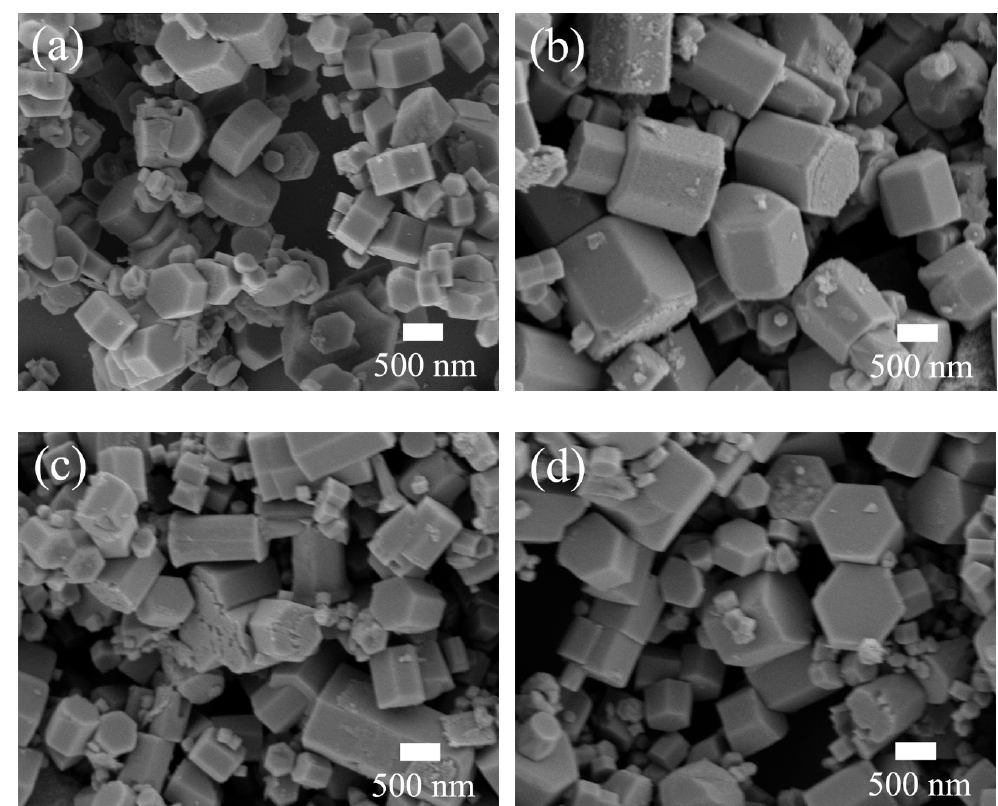
Figure 2. SEM images of undoped ZnO ( a ) and lightly Cu-doped ZnO nanocrystals with different Cu concentrations: ( b ) 0.25%, ( c ) 0.5%, and ( d ) 1%. concentrations: ( b ) 0.25%, ( c ) 0.5%, and ( d )